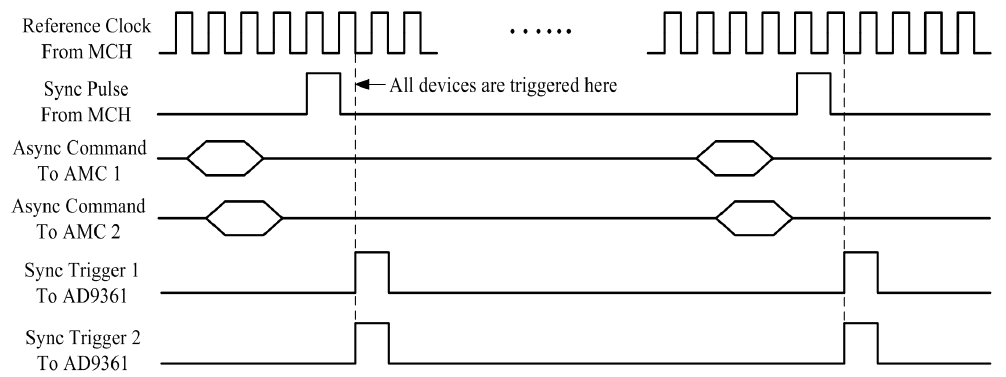
Figure 8. Frontend in-chassis synchronization timing sequence.